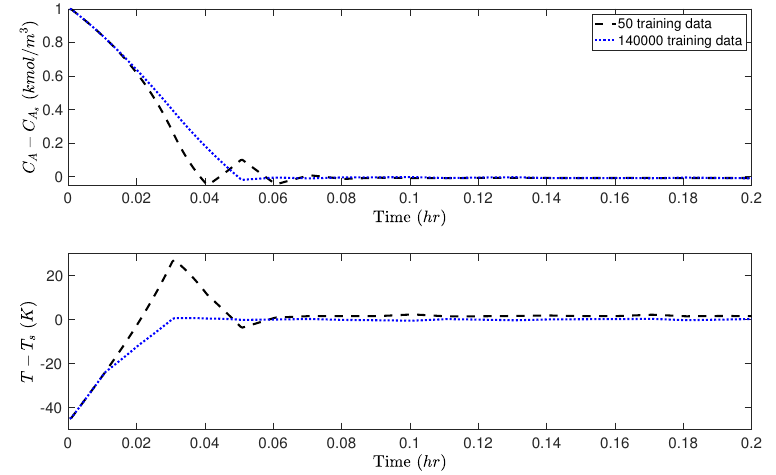
Figure 12. Closed-loop state profiles under LMPC using two RNN models trained with different data sample